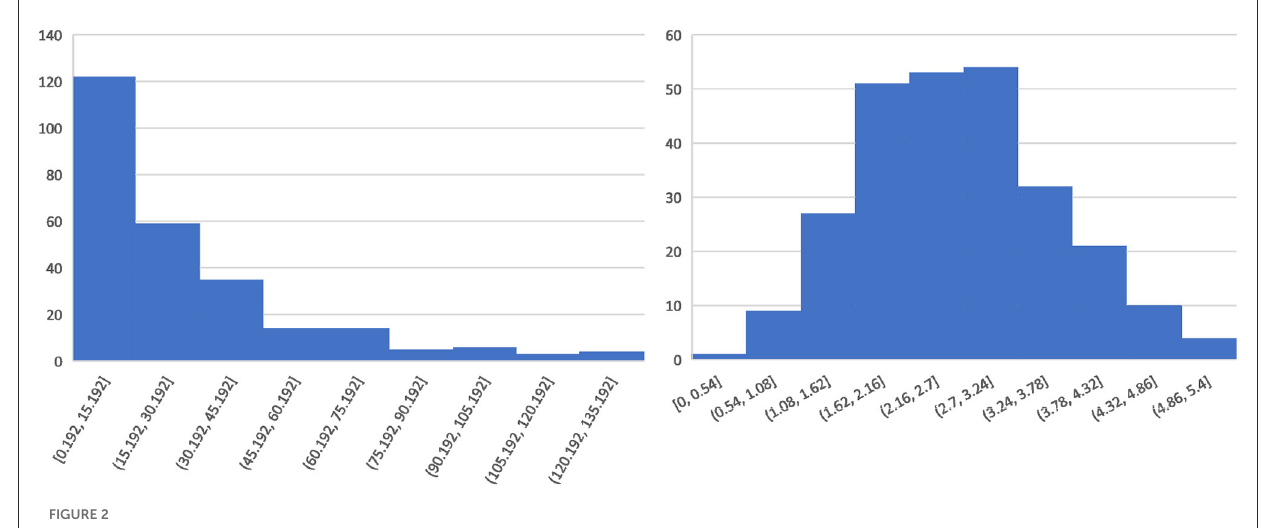
FIGURE2 Histogram of the blood loss distribution.